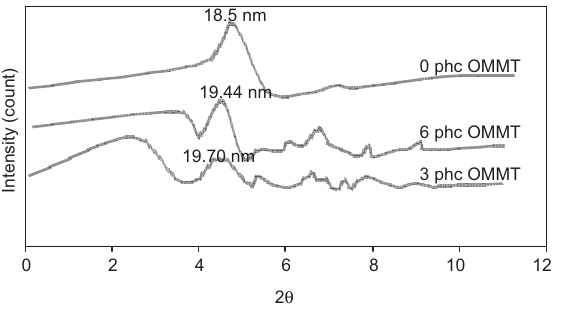
Figure 1 X-ray diffraction (XRD) patterns of composites with differ- ent levels of organomodified montmorillonite (OMMT).